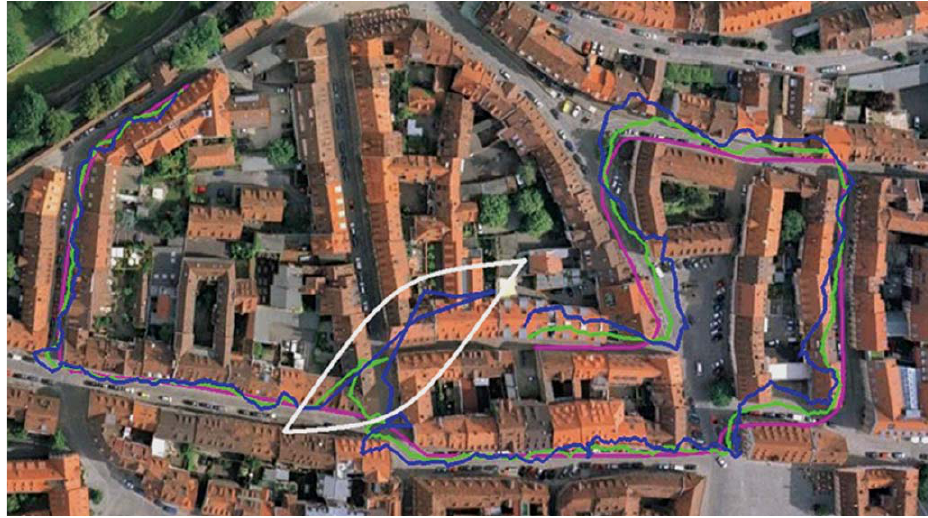
Fig. 7. GPS-Multipath in the city centre of Nuremberg and the better performance by means of IMM [GPS (blue); WPS (cyan); IMM (green)]